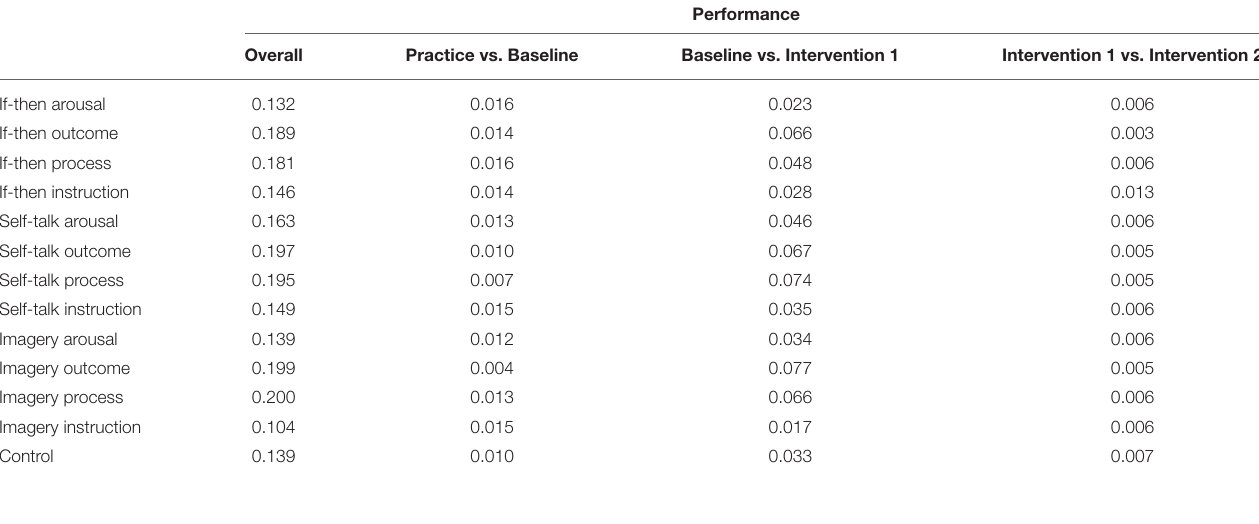
TABLE 2 | Effect sizes for differences in performance and emotion for each group.